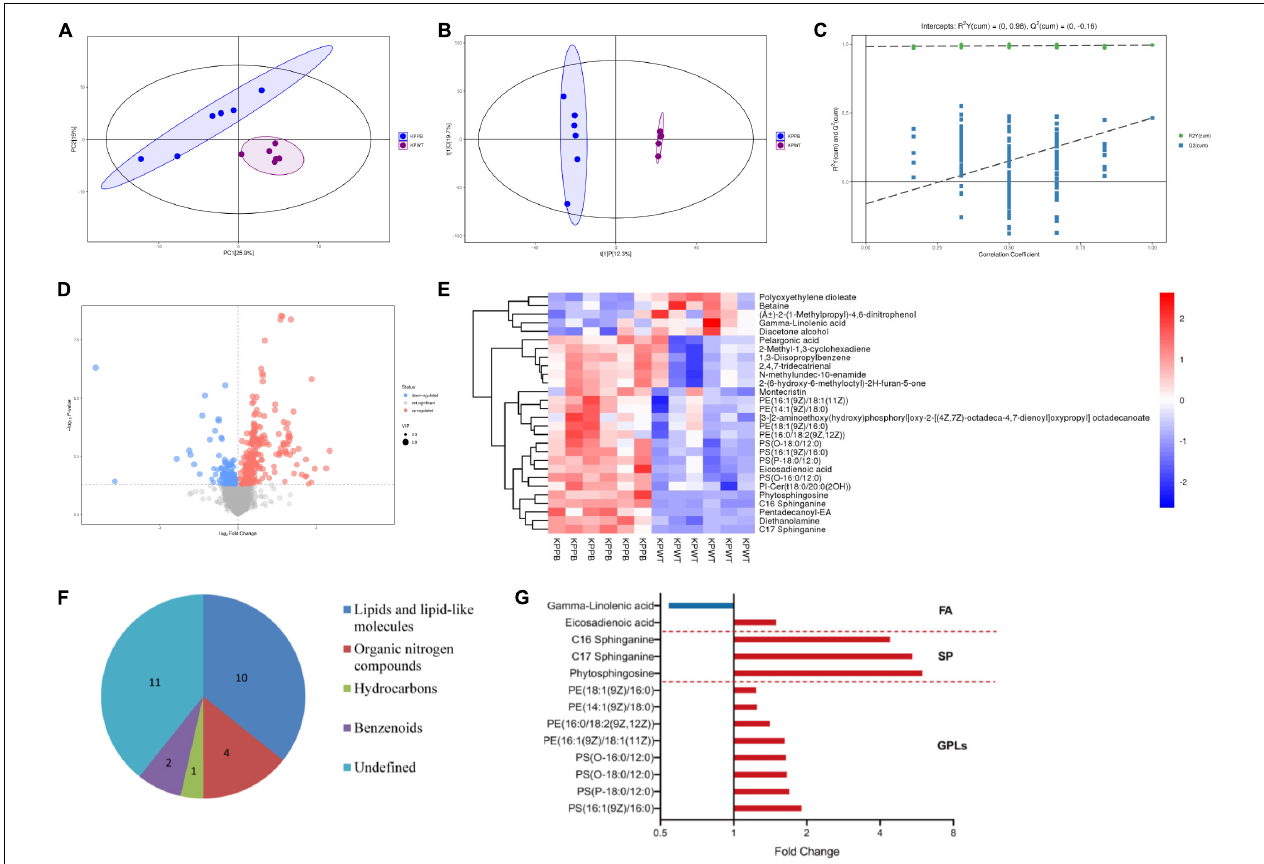
FIGURE 6 | Analysis of the metabolic data. (A) Principal component analysis (PCA) score plot. Blue dots represent PB-resistant strains and purple dots represent PB susceptible strains ( n = 6). (B) Orthogonal projection latent structure discrimination analysis (OPLS-DA) score plot. (C) OPLS-DA permutation plot. (D) Volcano plot shows expression of differential metabolites between PB-resistant and -susceptible K. pneumoniae . Diameter of each dot is determined by its VIP value. Upregulated and downregulated metabolites are shown in red and blue, respectively. (E) Heatmap shows the expression pattern of differentially expressed metabolites. (F) Classification information of the differential metabolites based on HMDB database. (G) Fold change of the significantly changed lipids in the PB-resistant K. pneumoniae . Red bars represent the lipids with increased abundance in PB-resistant strains, and blue bars represent lipids with decreased abundance. GPLs, glycerophospholipids. SP, sphingolipid. FA, fatty